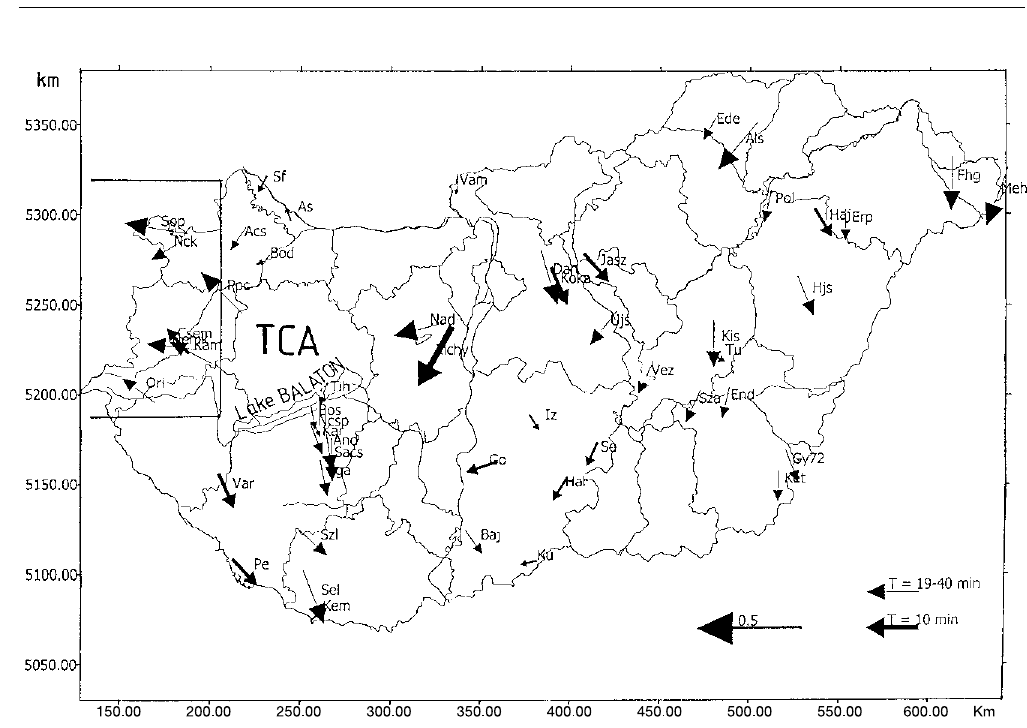
Fig. 1. Real Wiese induction arrows (vectors) measured at a given period in Hungary.